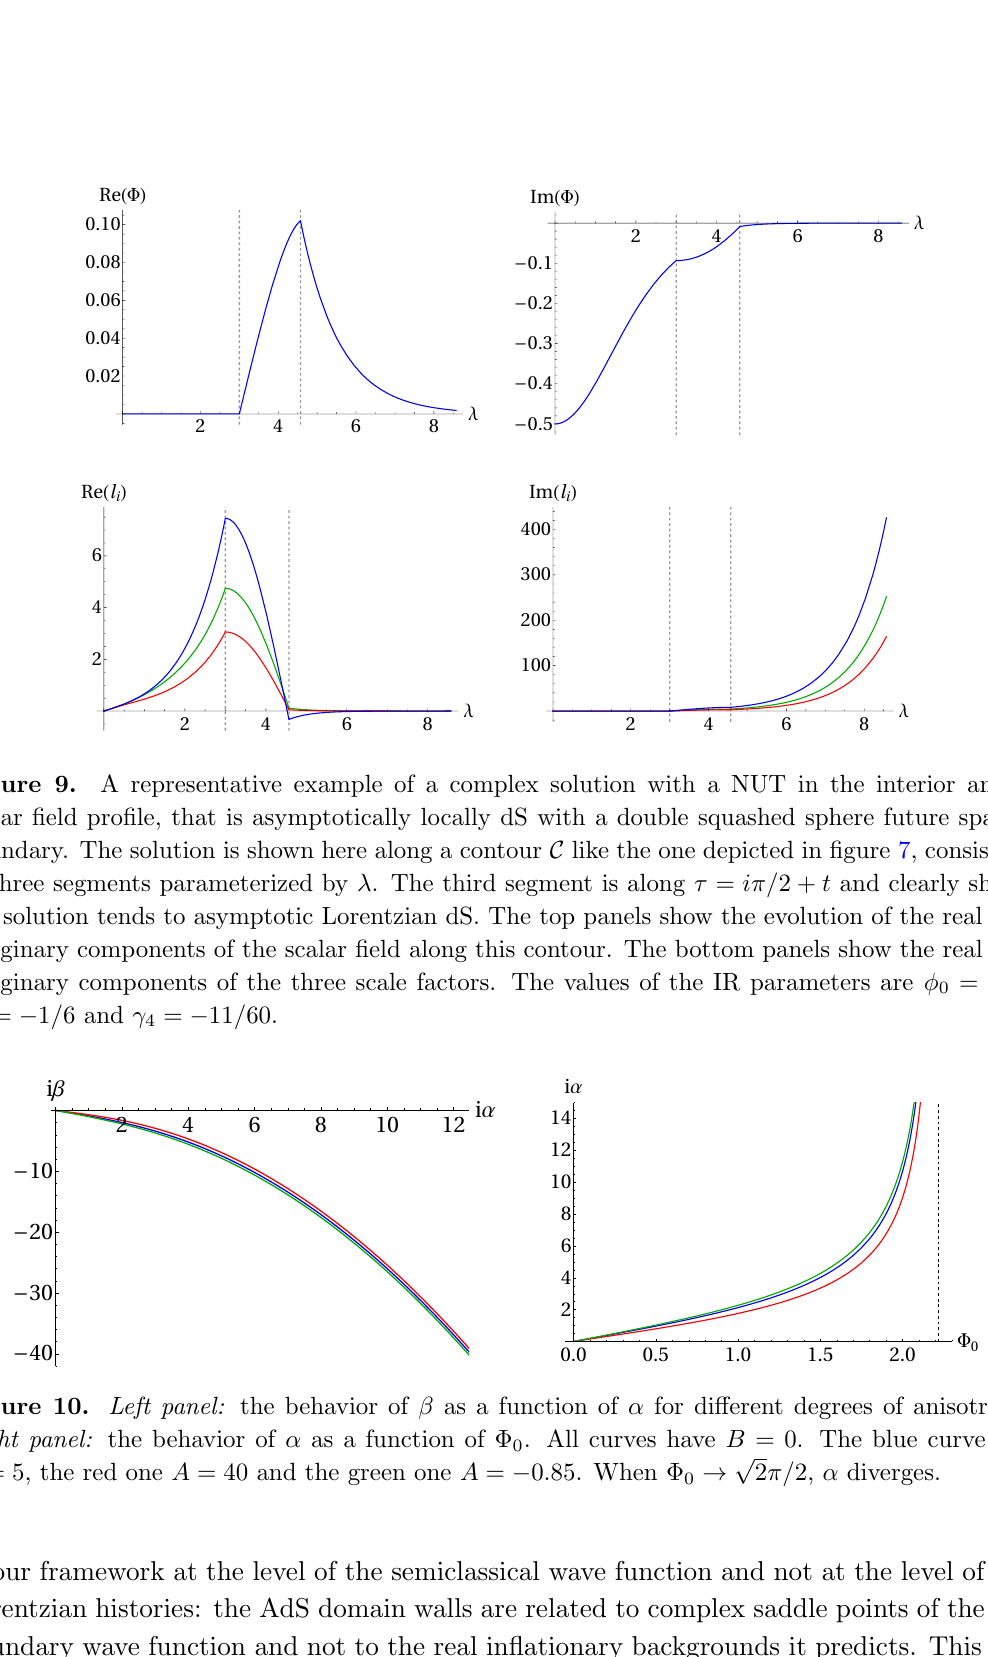
p 2 (cid:25)= 2, (cid:11)